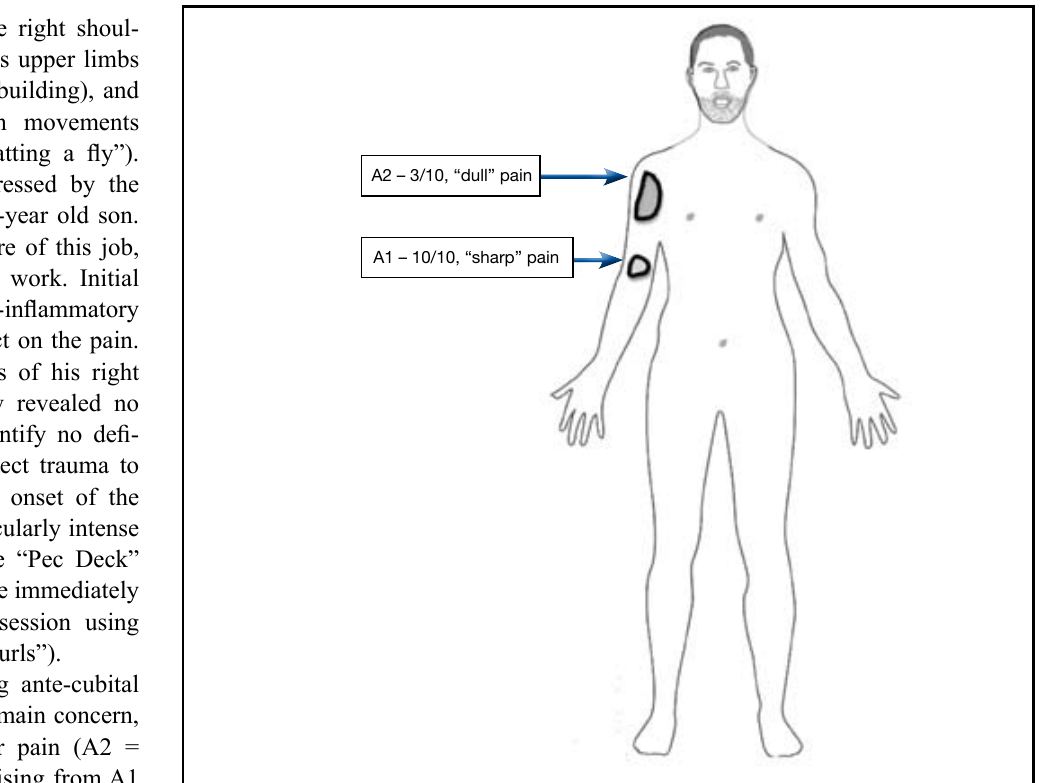
Figure 1: Body chart of Mr